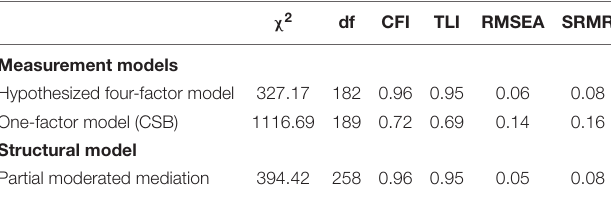
TABLE 1 | Models and fit